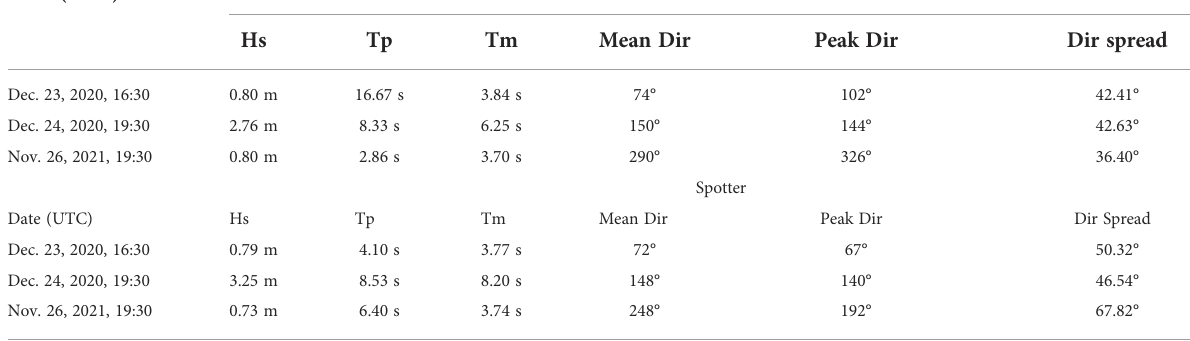
TABLE 2 Bulk wave statistics for the three time periods shown in Figure 8